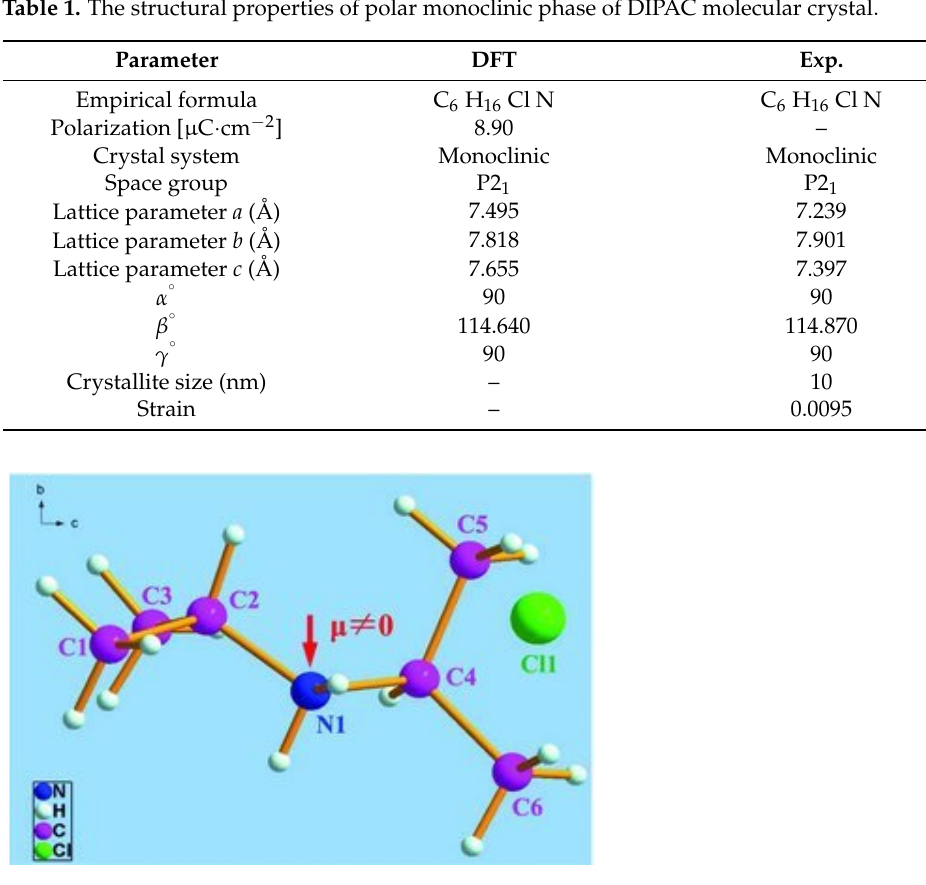
Figure 3. A schematic diagram of the DIPAC polar crystal.